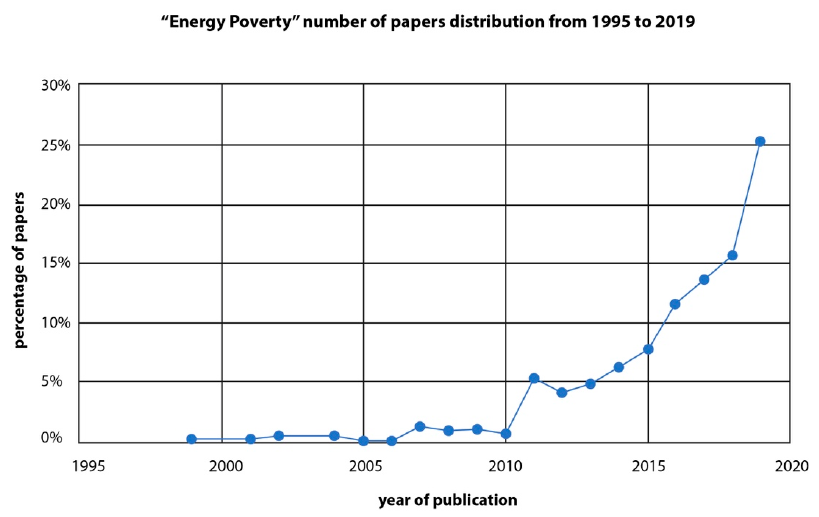
Figure 2. The image shows the growth of the number of papers from 2000 to 2019.